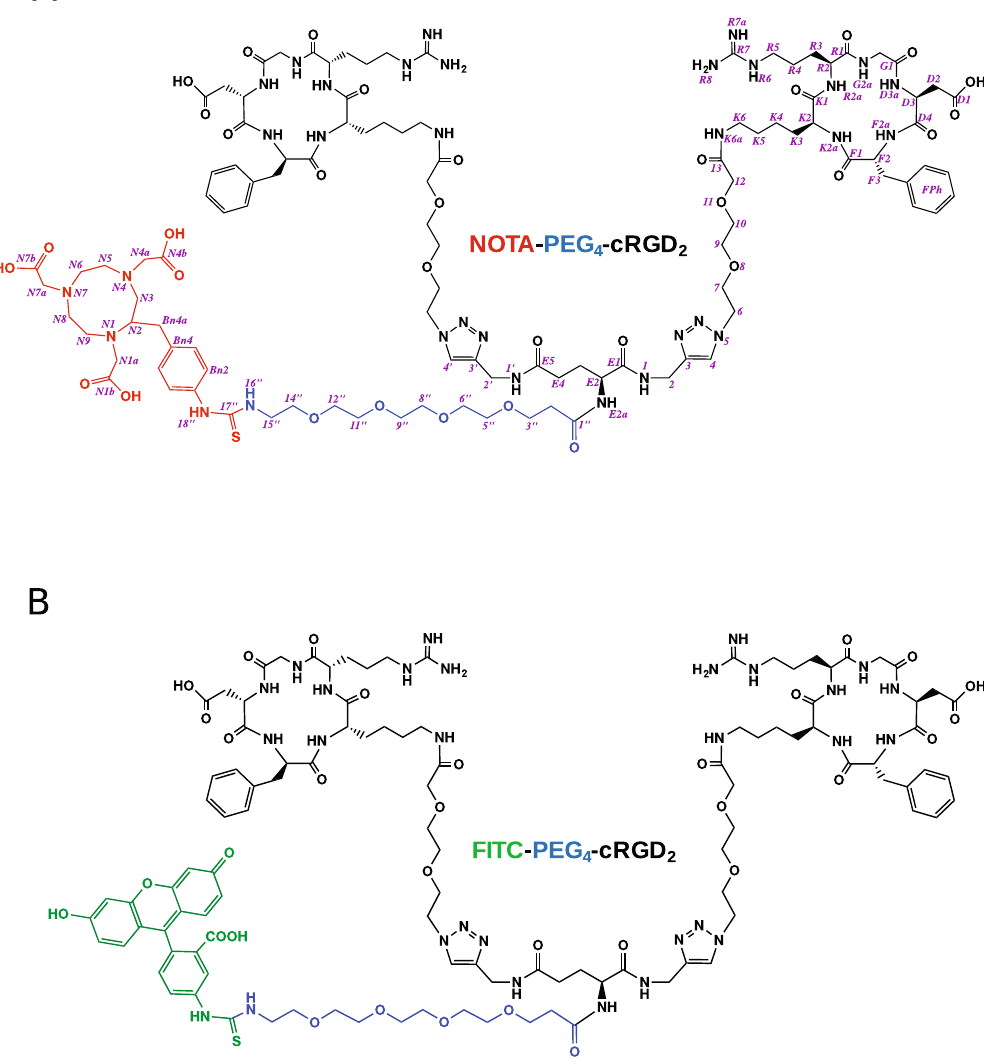
Figure 1. Chemical structures of ( A ) NOTA-PEG 4 -cRGD 2 and ( B ) FITC-PEG 4 -cRGD 2